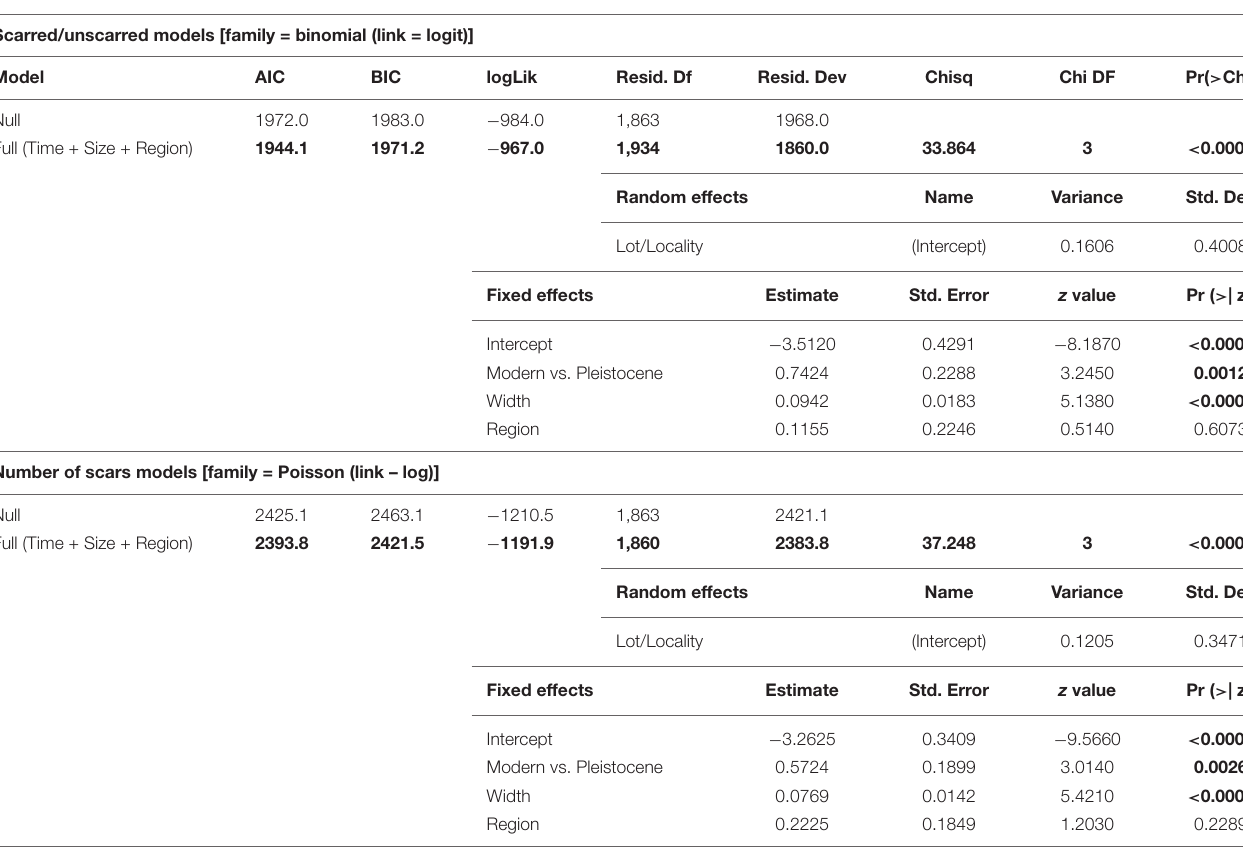
TABLE 2 | Mixed models results of Pleistocene vs. modern repair scars, size, and